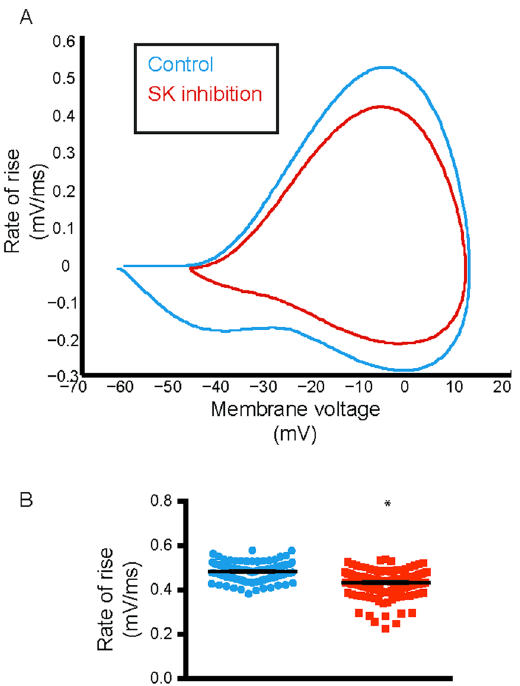
Figure 5. SK channel inhibition causes a decrease in rate of rise in membrane voltage. Phase-plane plot showed a clear reduction in rate of change in membrane voltage during a simulated SK channel inhibition ( red ) compared to control ( black ). ( B ) This was quantified by a significant decrease in the maximum value of rate of rise of membrane voltage, which is indicative of sodium channel unavailability. Error bars indicate mean ± S.E.M, not visible due to small